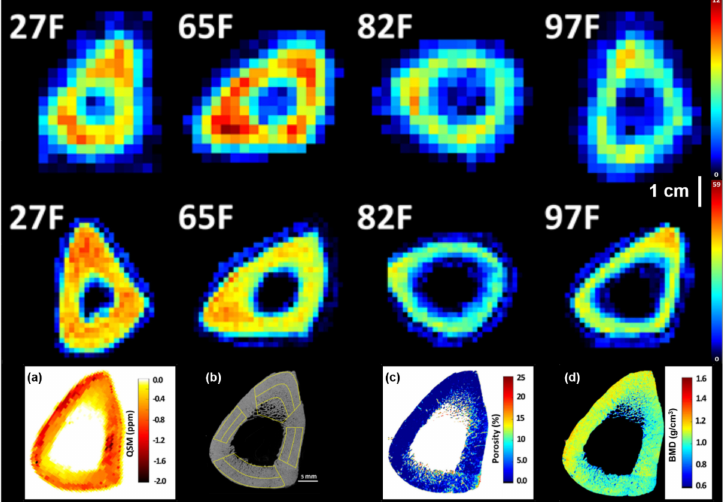
Figure 2. Solid state MRI and quantitative susceptibility mapping. (first row) Maps of bone mineral 31 P density, and bound water density (second row) in central slices of 4 human tibial cortical bone specimens. Age and gender of bone specimen donors are indicated. Bone mineral 31 P and bound wa- ter 1 H densities are markedly lower in bones from elderly female donors than from younger females or males. 31 P maps also suffer from increased point spread function blurring because of the lower gyro- magnetic ratio and shorter T2 * of 31 P. (reproduced from NMR Biomed. 27: 739–748 (2014)) (third row) ( a ) QSM map obtained through Cones 3D UTE-MRI scans (0.5 mm × 0.5 mm × 2 mm voxel size) of a tibial midshaft cortical bone (45-year-old female), ( b ) one µ CT slice at 9 µ m isotropic voxel size, ( c ) µ CT-based porosity, and ( d ) BMD map of the same specimen. Local maxima in the QSM map correspond to high BMD regions and low porosity values in µ CT-based maps (reproduced from Magn. Res. Im. 62: 104–110